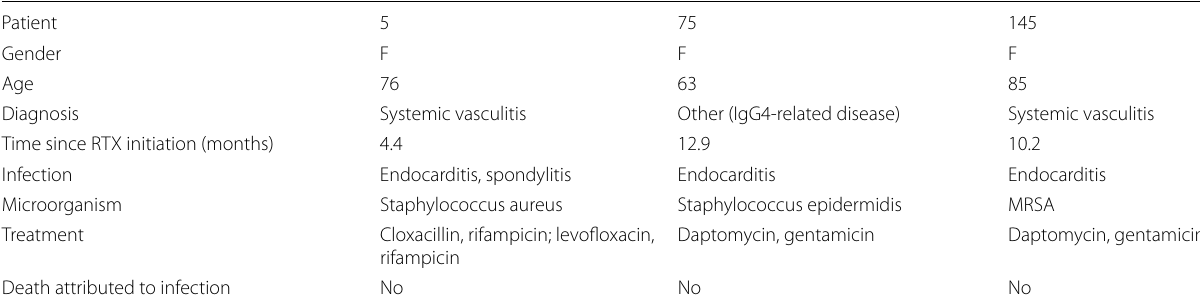
Table 1 Three cases of endocarditis post RTX therapy [7]